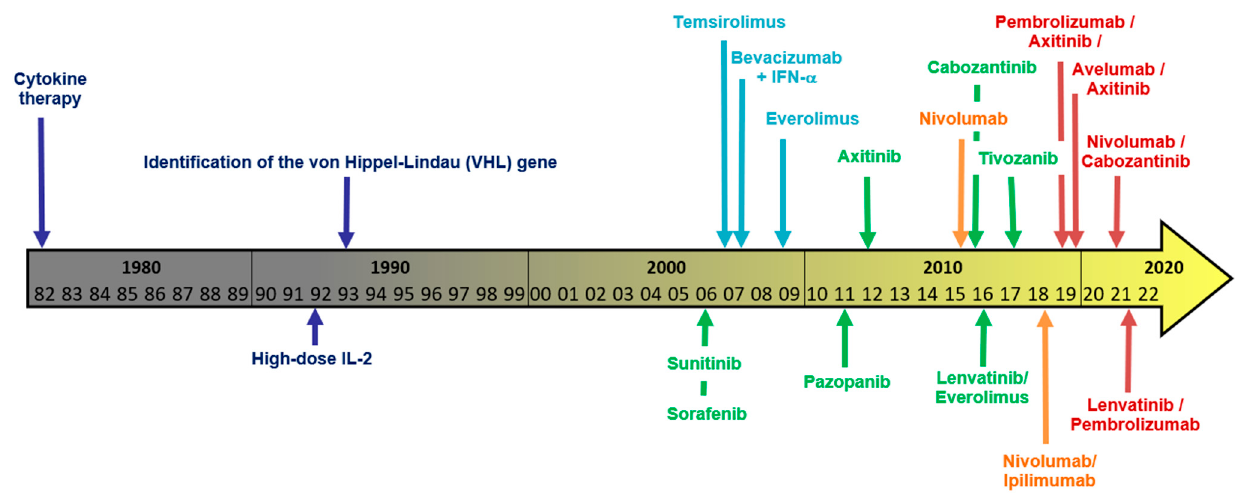
Figure 1. Evolution of treatment options for metastatic RCC—“from the dark to the golden age?”—timeline of mRCC treatments. Letter colours: Dark blue: Early milestones; green: TKI-containing regimens; orange: IO and IO–IO combination therapy; red: IO–TKI combination therapy; light blue: Other systemic therapies (non ‐ TKI/non ‐ IO).